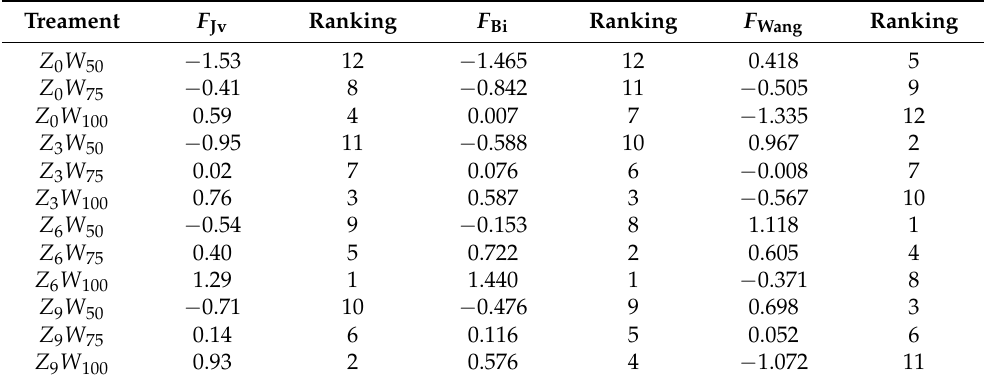
1.29 Z 9 W 50 − 0.71 − 0.476